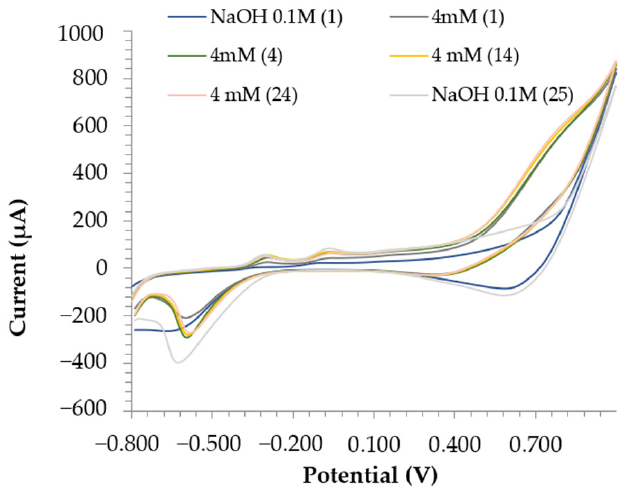
Figure 9. Repeatability of copper oxide electrode. 25 measurements of 4 mM of glucose in 0.1 M NaOH. (x) refers to electrode measurement repetition number.